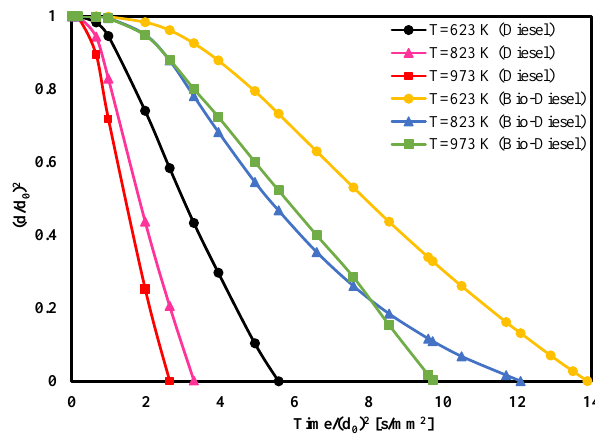
Figure 4. Variation of 20-micron droplet’s dimensionless diameter at various ambient temperatures.